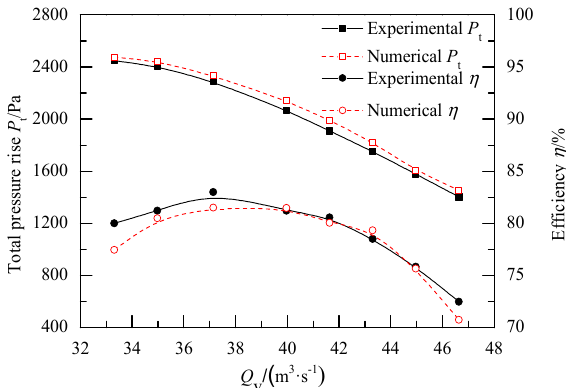
Figure 4. Comparison of simulated and experimental results.